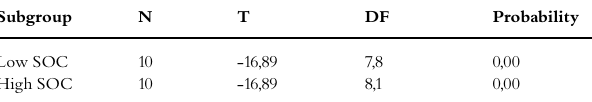
TABLE 2 T-TEST RESUTS THESIGNIFICANCEOF DIFFERENCE